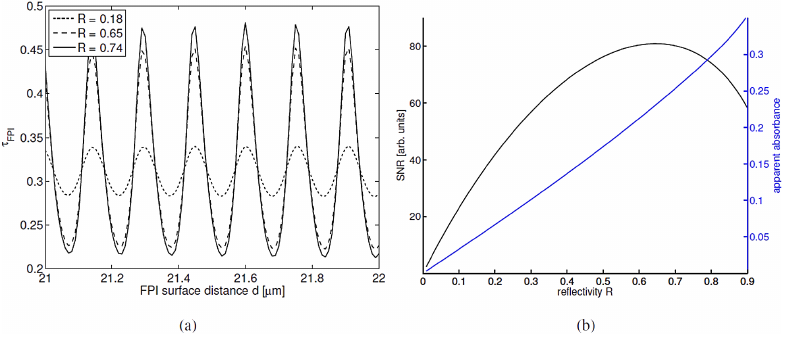
Figure 3. (a) Optical density τ for an SO 2 slant column density S SO between the surfaces, calculated for FPI reflectivities of 0.18, 0.65 and 0.74. The difference in the optical densities recorded at maximum ( d A at, e.g., 21.6µm) and minimum ( d B ) values is the apparent absorbance. (b) The apparent absorbance (blue line) grows monotonically with the reflectivity R . However, for high R (and thus for high F ), the SNR is decreasing, since less radiation is transmitted.